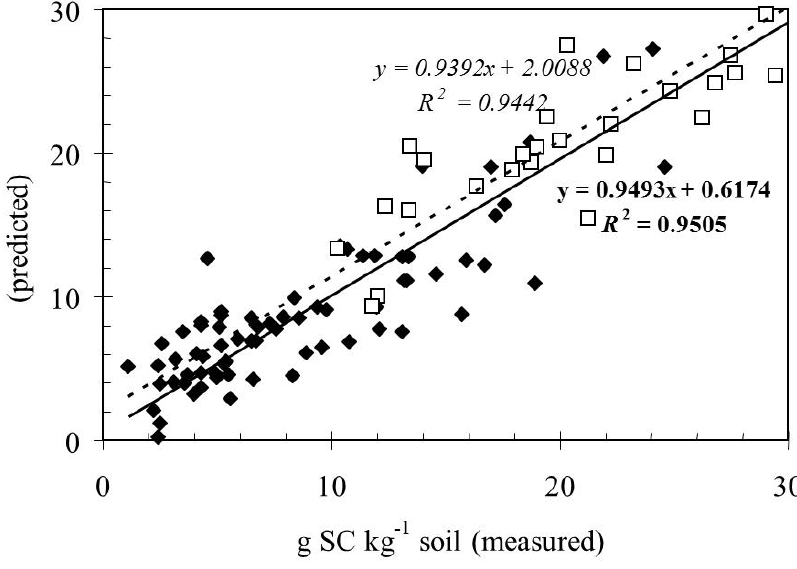
Figure 4. Actual values and predicted values (g kg − 1 ) comparing our data for Pantelleria (filled diamonds) and the data obtained by D’Acqui et al. [17] in the island of Pianosa (open squares) in the range of three percent carbon content of